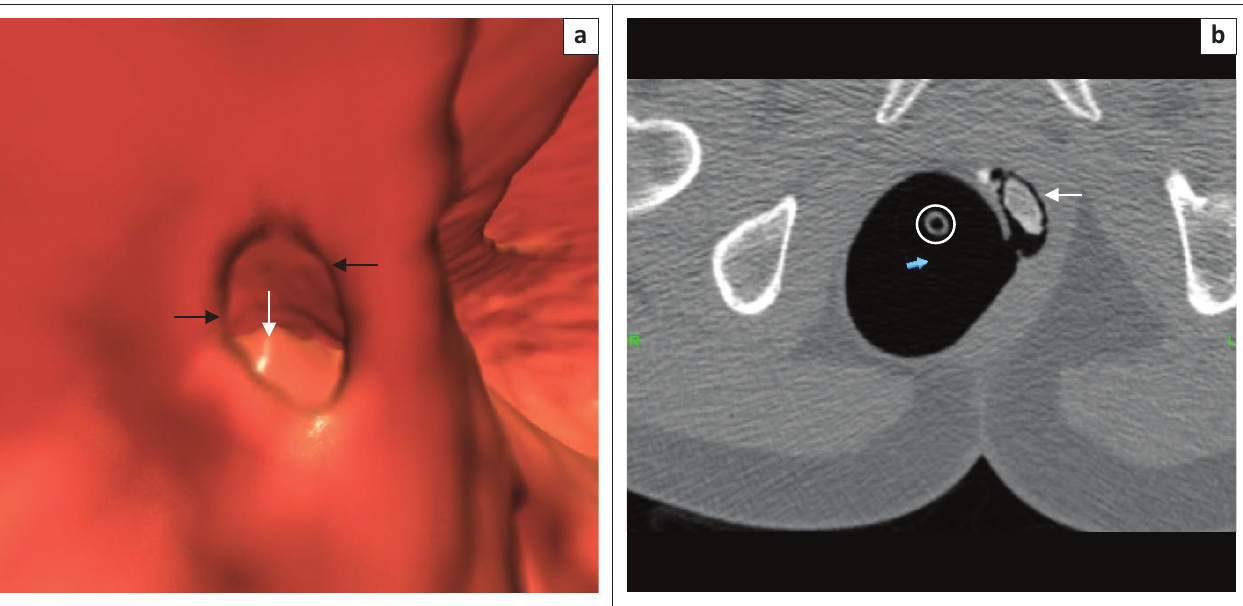
FIGURE 18: (a) 3D view of a ‘contained’ perforation of rectum (black arrows). Calcified enterolith (white arrow); (b) 2D axial view shows a ‘contained’ perforation and calcified faecalith (white arrow) and rectal catheter (white circle).